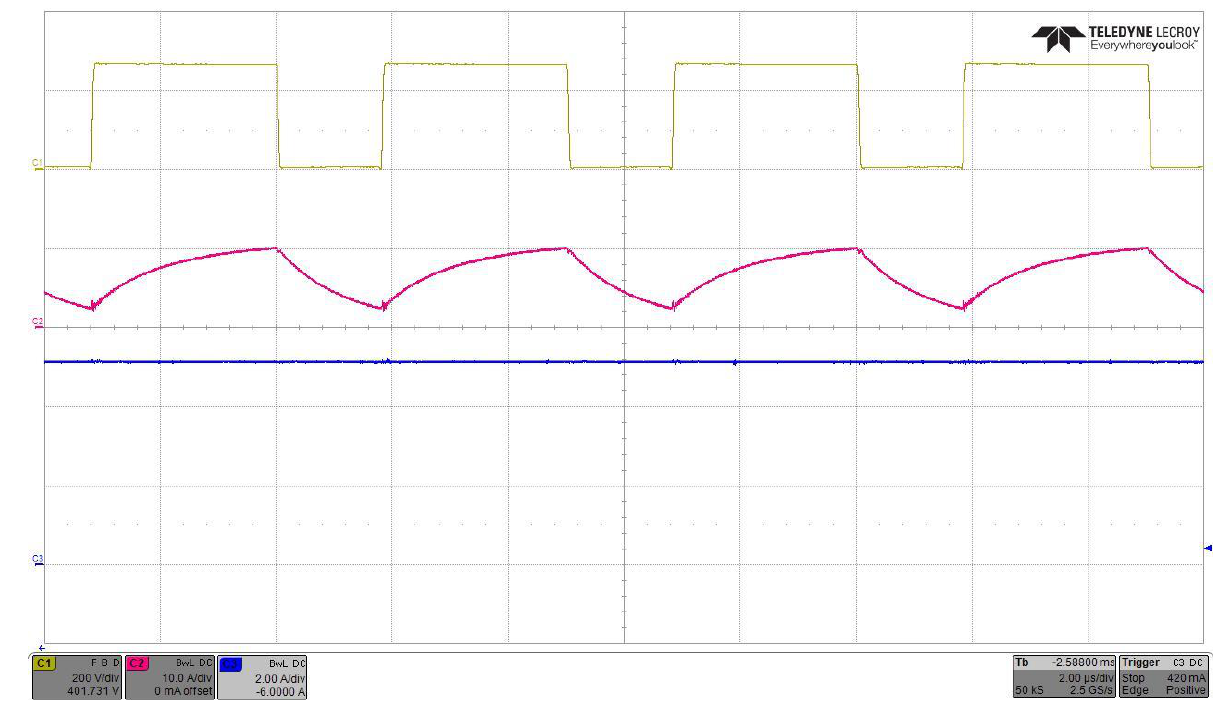
Figure 14. Response of the proposed SMC in steady-state operation (load voltage (yellow), load current (purple), and input/EMA current (blue)).